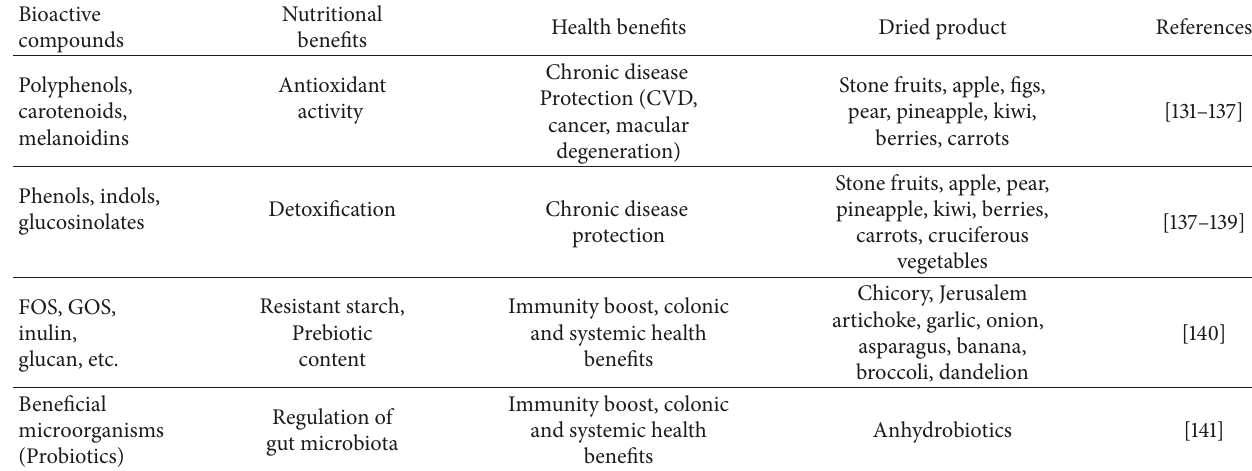
Table6:Mainbioactivecompoundsresponsiblefornutritionalandhealthbenefitsofplantderiveddriedfoodproducts(fruitsandvegetables, fruits and vegetable by-products, grains, nuts, and